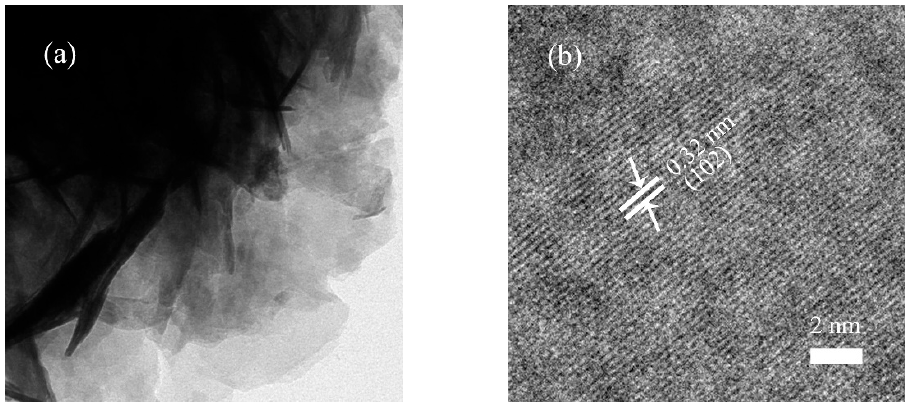
Figure 4. ( a ) Low magnification scanning electron microscope (SEM) image; ( b ) high magnification SEM image of the 1.5L-ZIS sample.